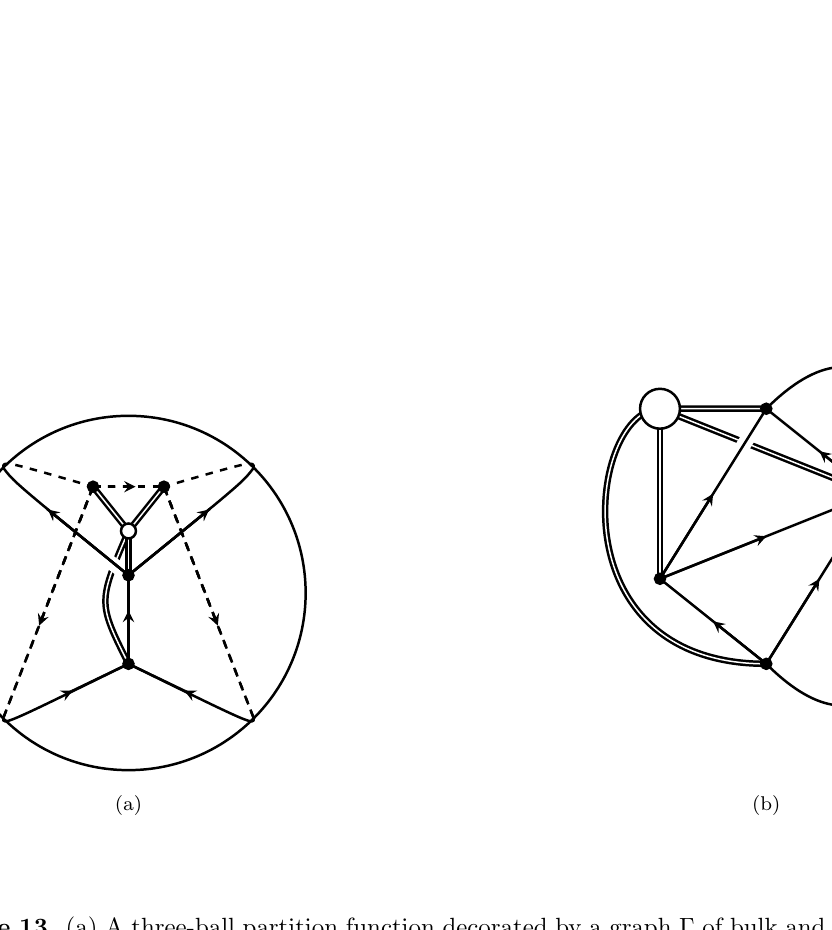
Figure 13 . (a) A three-ball partition function decorated by a graph (cid:0) of bulk and boundary lines. (b) The graph is projected onto the sphere for evaluation. The di(cid:11)erent projections evaluate to the same result, thanks to the Drinfeld center axioms.